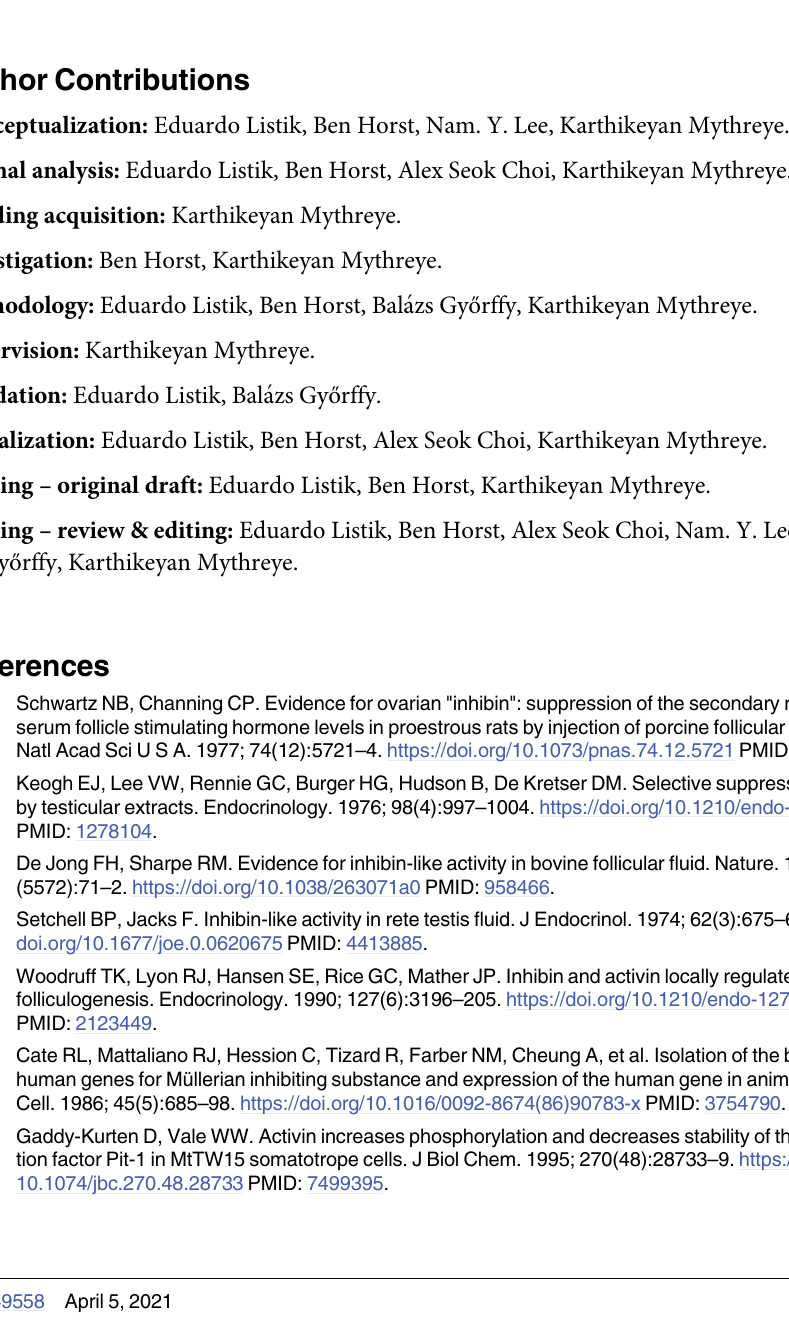
S2 Table. Complementary table for survival data. S3 Table. Full data concerning ROC analysis. S4 Table. INHA, TGFBR3 and ENG survival gene signature full data discrimination. S5 Table. Probit regression detailed outputs. S6 Table. INHA-TGFBR3-ENG pairwise gene comparison